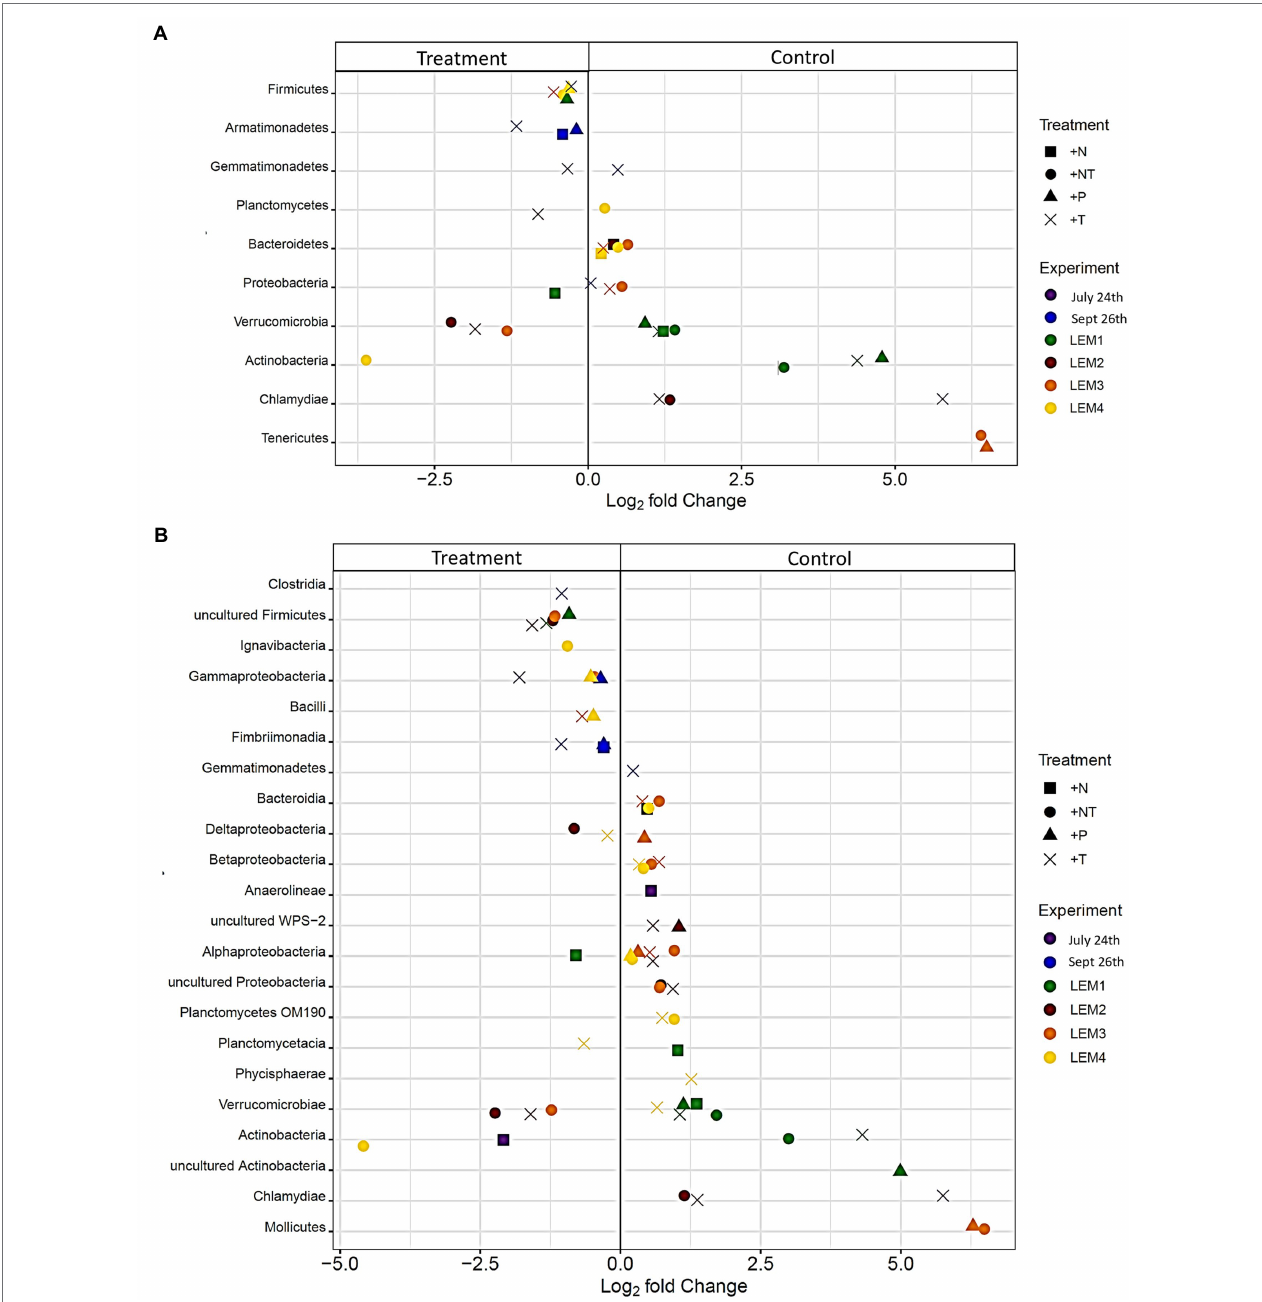
FIGURE 5 | Bacterial taxa found to be significantly differentially abundant between the control and treatments among the experiments ordered by degree of fold change. Points with positive log fold changes are significantly enriched in the control, points with negative log fold changes are significantly enriched in the treatment with taxonomy divided by (A) phyla and (B)